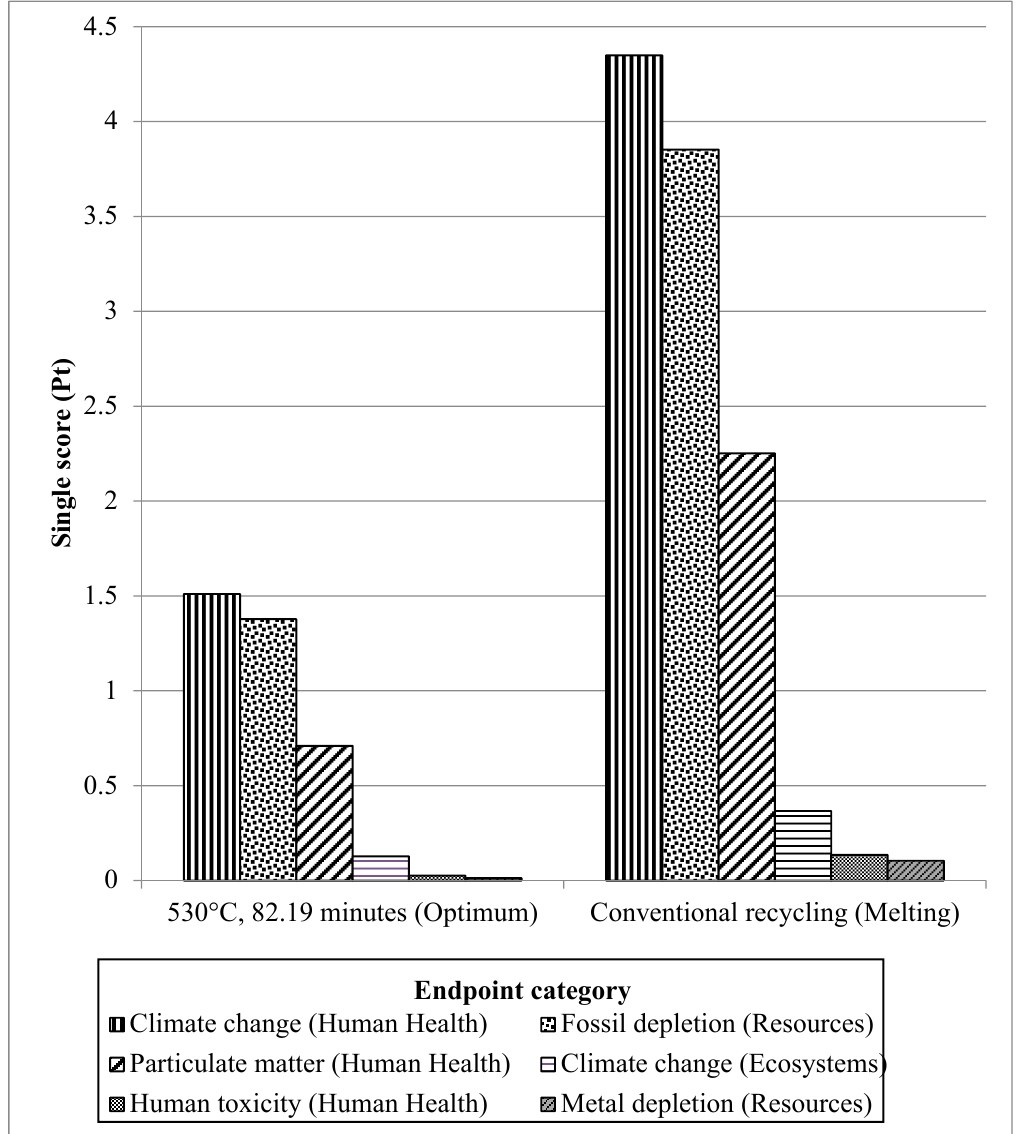
Figure 11. Relative performance (per impact categories) of DR-HPF process and CR of aluminum.